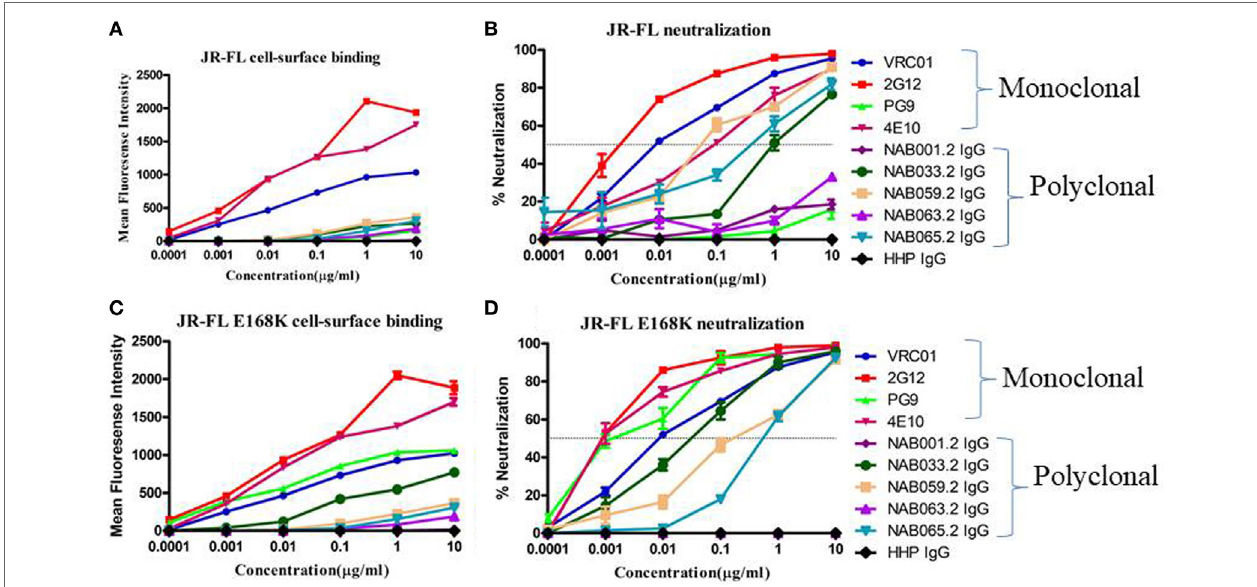
FigUre 7 | Cell-surface binding and neutralization analysis of IgG eluted from BCN samples. (a,c) Cell-surface binding assay with IgG eluted from BCN samples and control mAbs with JR-FL WT and JR-FL E168K mutant Env trimers expression on the surface of 293 T cells as determined by their mean fluorescence intensity in flow cytometry. (B,D) Neutralization activity of IgG from BCN samples and control mAbs against JR-FL WT and JR-FL E168K mutant pseudoviruses. VRC01, 2G12, PG9, and 4E10 were included for comparison as positive controls and HHP IgG was used as negative control. Each experiment was performed in duplicate on two independent